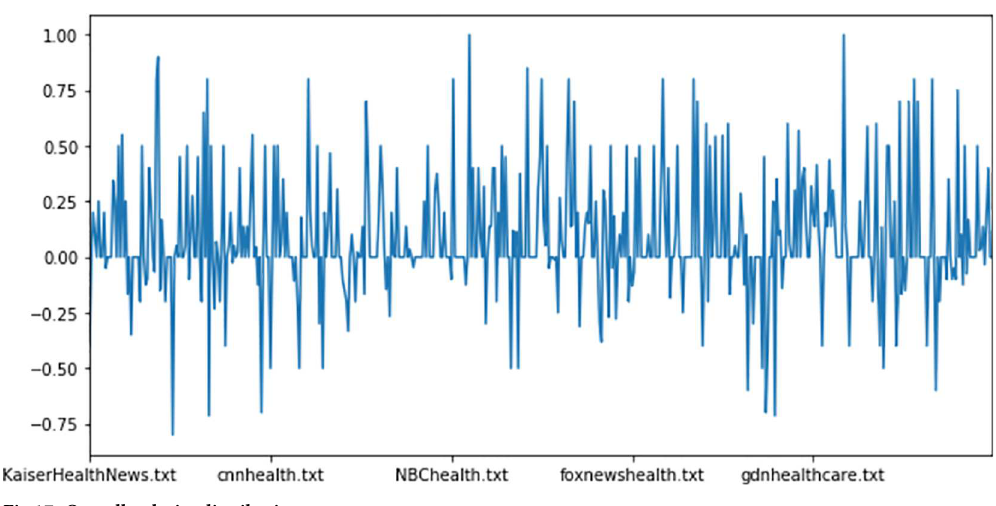
Fig 17. Overall polarity distribution.